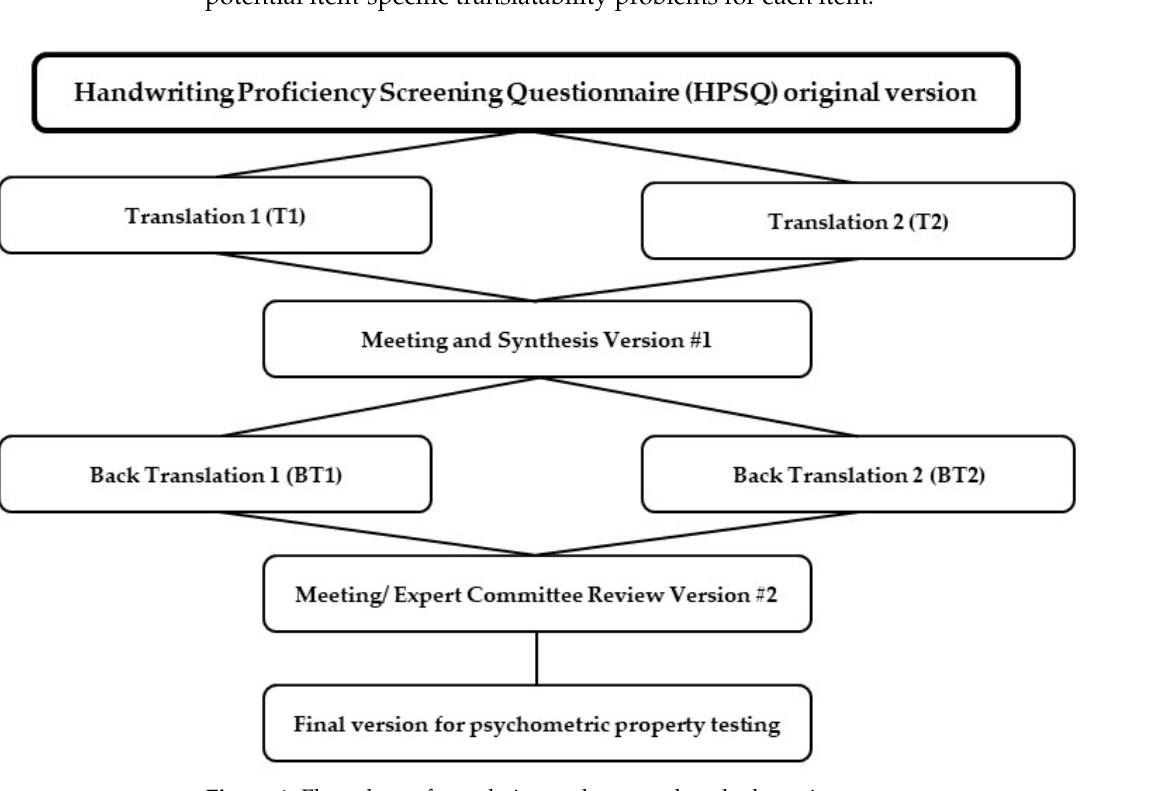
Figure 1. Flow chart of translation and cross-cultural adaptation process.